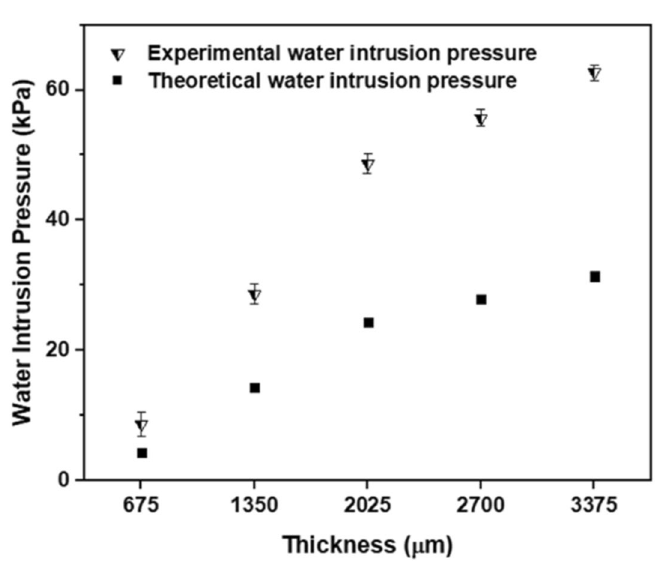
Figure 7. Experimental and theoretical water intrusion pressure of modified (superhydrophobic) GMF